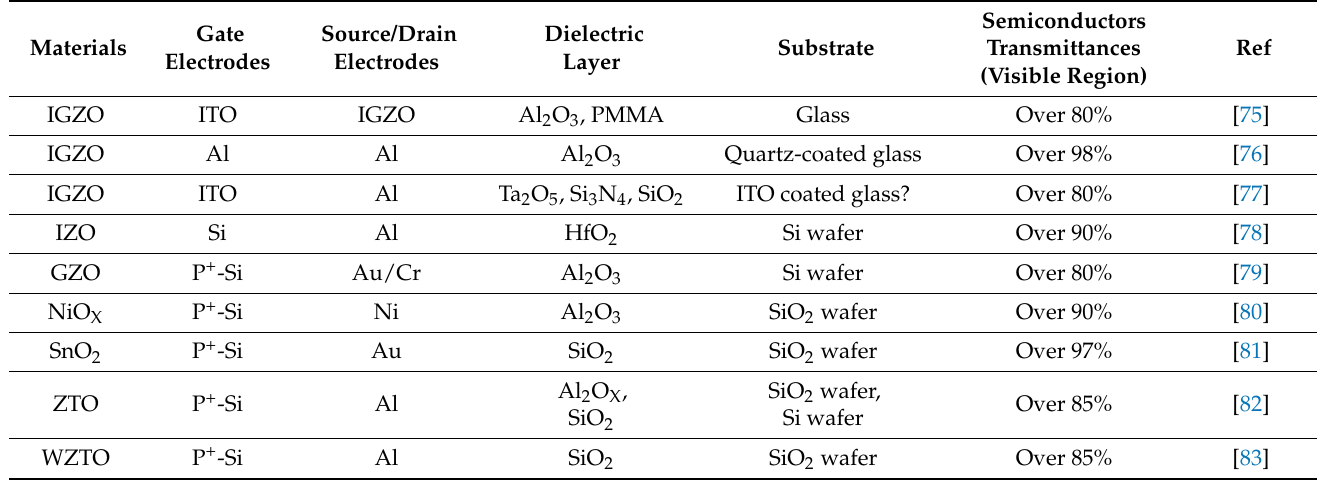
Table 2. Transmittance of metal-oxide semiconductor-based